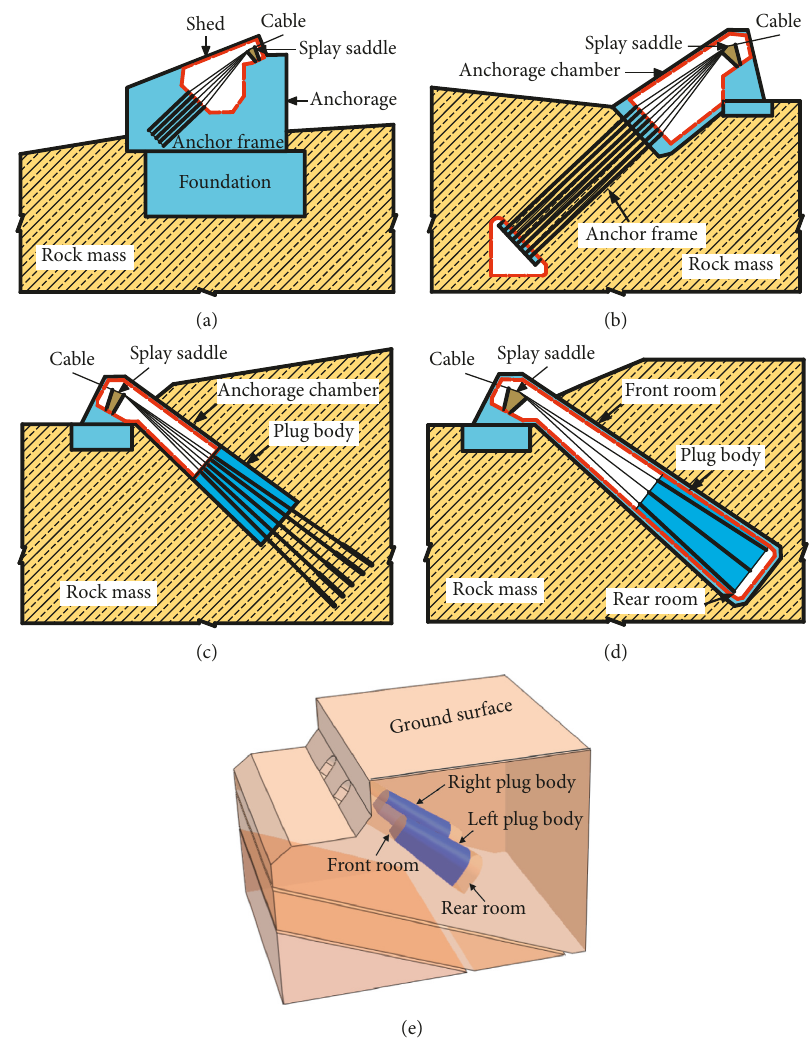
Figure 2: (a) Gravity-type anchorage. (b) Rock anchorage. (c) Compound anchorage. (d) Tunnel-type anchorage. (e) Schematic of spatial arrangement of